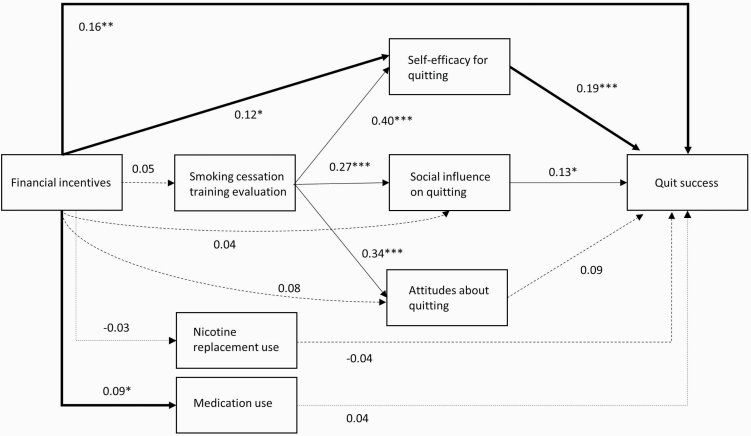
Path analysis model with unstandardized regression coefficients assessing the pathways between financial incentives and quit success. Available case analysis with multiple imputation (n = 604), and with random intercepts at company level. Solid arrows depict statistically significant pathways, dashed lines depict nonsignificant pathways. Thick arrows represent significant direct and mediational pathways from financial incentives to quit success. Only pathways of interest are shown. Control variables were omitted from the figure for simplification. *p < .05; **p < .01; ***p < .001.